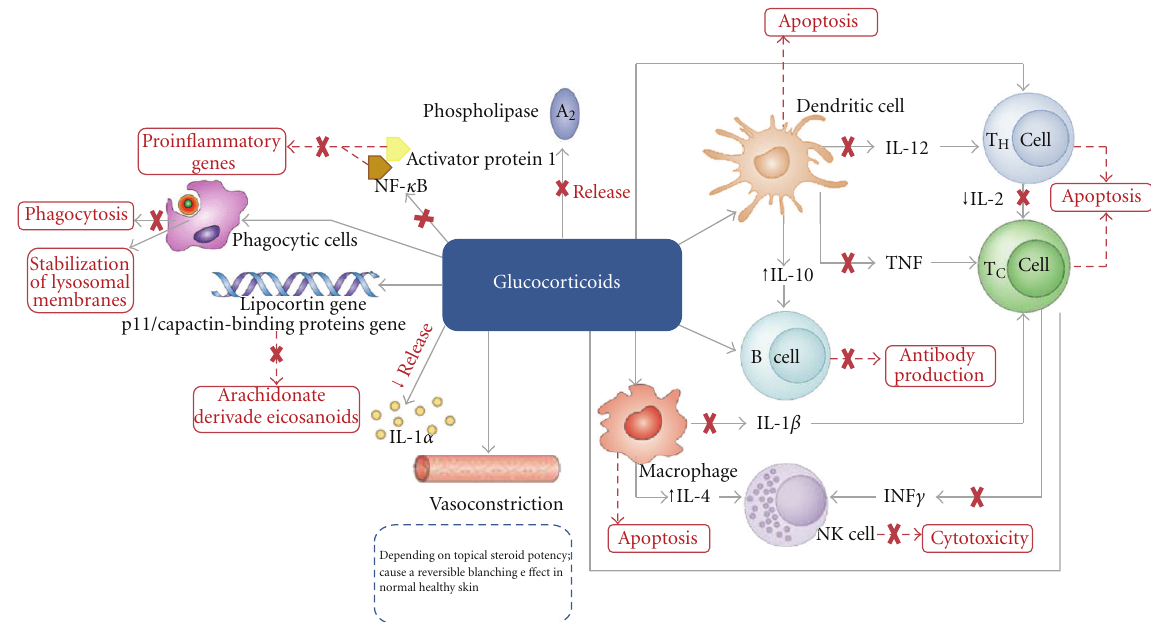
Figure 2: Anti-inflammatory, immunosuppressive, and vasoconstrictive e ff ects of topical corticosteroids [13, 14].